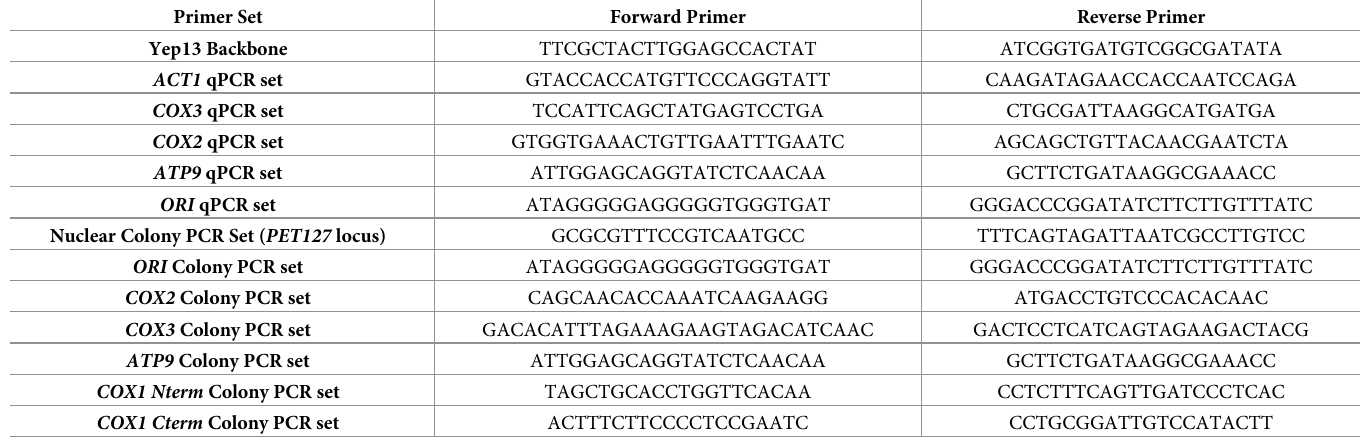
Table 3. List of Primers Used in this